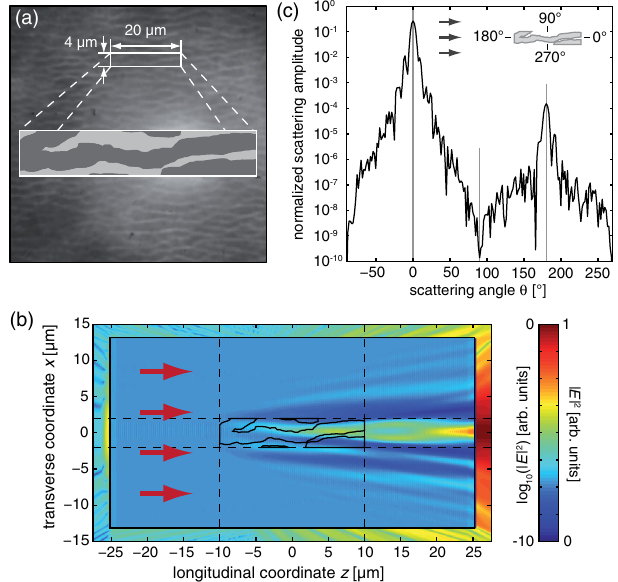
FIG. 3. Sketch of the diffuse intensity. (a) A waveguide structure consisting of a guiding layer packed between two FIG. 4. Estimation of scattering amplitudes. (a) Microscope cladding layers. The mode profile in the y direction is localized image of one of the samples illuminated from the back by an in the guiding layer (light blue solid line). The excited mode infrared diode. Inset: Filtered and extracted structure used in the defines an effective refractive index n . The waveguide is of FDTD simulation, where the light gray section is considered as a eff length L in the z direction and practically infinite in the x part of the background and the dark gray section constitutes the direction. (b) Schematic normalized diffuse intensity for a source actual defect with varying refractive index. (b) Numerical result ¼ 1 . The length of the waveguide L is taken to be located at l of the FDTD simulation for plane wave excitation (contour of trans 10 and z 0 ¼ 1 . Depicted are the cases for vanishing absorption defect plotted for reference) and index variation Δ n ¼ 0 . 001 . The ¼ 3 (red solid line). (c) Fit (red (dark blue solid line) and L absolute value of the total field is displayed in the inner rectangle, loss solid line) to the experimentally determined mean total trans- while the scattered field is shown in the outer frame (see =P mission T ð L Þ ¼ P (gray squares) for cw operation as respective color scale). Most of the radiation is scattered to out in measured at the rear facets of the samples, based on Eq. (17). We the front. Only a small part is backscattered and the radiation ¼ 5 . 40 mm and l ¼ 1 . 87 mm. Note the logarith- obtain L scattered to the sides is negligible. (c) Plot of the angle-dependent loss trans mic scale, which amplifies errors at low transmission values. The scattering amplitudes for the index structure depicted in (a) for fit function is dashed for L < 2 l , since Eq. (16) is reasonable illumination with a plane wave polarized parallel to the plane of trans only for L ≥ 2 l . The light red corridor illustrates the func- incidence (TE polarized in terms of the waveguide structure). trans tional prediction bounds for 1 σ . A fit based on a model with non- negligible losses along l (green solid line) does not result in a trans better